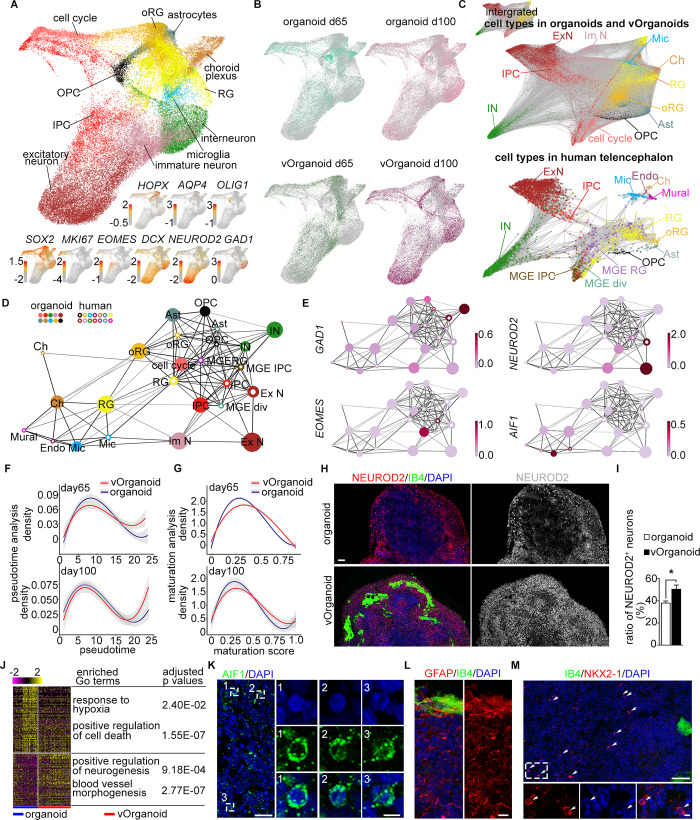
Cell type mapping between the scRNA-seq data of organoids and human fetal telencephalon.(A) Visualization of the major cell types in organoids and vOrganoids by 3D UMAP. Each dot represents one individual cell and colored by cell types. The expression of known gene markers was visualized at the lower panel and cells were colored by the expression level (red, high; gray, low). (B) The cell distributions of control organoids and vOrganoids at d65 and d100, respectively, were individually showed using UMAP. Each dot represents one individual cell and colored by sample information. (C) The scRNA-seq data of organoids and human fetal telencephalon were integrated to display the cell similarities in forced-directed graph. The integrated data were showed in the top left zoomed-out plot. Meanwhile, the cell distributions of organoids and human fetal telencephalon were highlighted separately. Each dot represents a single cell and is colored according to the cell types in the integrated data. The width of edges is scaled with cell–cell connectivity. (D) The correlations among cell types are displayed in the PAGA graph. The cell types in the organoids and human fetal cortex datasets were denoted by the solid and hollow dots, respectively. And the same cell types in two datasets were colored identically. The size of dots was scaled with the cell numbers; width of edges was scaled with the connectivity between cell types. (E) The expression of the well-known gene markers in different cell types is showed in the PAGA plots. The GAD1, NEUROD2, EOMES, and AIF1 are the specific genes for interneuron, excitatory neurons, IPCs, and microglia, respectively. Nodes are colored according to the gene expression levels (light pink, low; dark red, high). (F) The fitted curves of cell density along the pseudo-time at day 65 (upper) and day 100 (lower) The shadow represents the confidence interval around the fitted curve. (G) The curves of cell density along the pseudo-maturation trajectory at day 65 (upper) and day 100 (lower). The shadow represents the confidence interval around the fitted curve. (H) Immunofluorescence staining for NEUROD2/IB4 in the control organoids and vOrganoids at day 65. The expressions of NEUROD2 are individually displayed in the right panel. Scale bar, 100 μm. (I) The ratio of NEUROD2+ excitatory neurons is higher in the vOrganoids than in the control organoids at day 65. n = 4, 4 control organoids and vOrganoids from three independent experiments. (J) Heatmap showing the expression of DEGs between the progenitor cells (included RG, oRG, cell cycle active cells, and IPCs) of control organoids and vOrganoids at day 65. The enriched gene ontology of the DEGs and the adjusted p-values are also listed. (K) Representative immunofluorescence staining figure for AIF1, a specific microglia marker, to illustrate the presence of microglia in organoids. Scale bar, 10 μm (left), 5 μm (right). (L) Immunofluorescence staining for GFAP to illustrate the presence of astrocytes in organoids. Scale bar, 10 μm. (M) A few of NKX2-1–positive cells are detected in the immunofluorescence staining section. The area in the white dashed box is magnified in the lower panel. Scale bar, 200 μm (upper), 20 μm (lower). The numerical as well as metadata underlying this figure can be found in the Fig 2A, 2B, 2C and 2I sheets of S1 Data. AIF1, allograft inflammatory factor 1; Ast, astrocyte; cell cycle, cell cycle active cell; Ch, choroid plexus; DEG, differentially expressed gene; Endo, endothelial cell; EOMES, eomesodermin; ExN, excitatory neuron; GAD1, glutamate decarboxylase 1; GFAP, glial fibrillary acidic protein; IB4, isolectin I-B4; ImN, immature neuron; IN, interneuron; IPC, intermediate progenitor cell; MGE, medial ganglionic eminence; MGE-div, MGE dividing cell; Mic, microglia; Mural, mural cell; NEUROD2, neuronal differentiation 2; NKX2-1, NK2 homeobox 1; OPC, oligodendrocytes progenitor cell; oRG, outer radial glia; PAGA, partition-based graph abstraction; RG, radial glia cell; scRNA-seq, single-cell RNA sequencing; UMAP, Uniform Mainfold Approximation and Projection; vOrganoid, vascularized organoid.